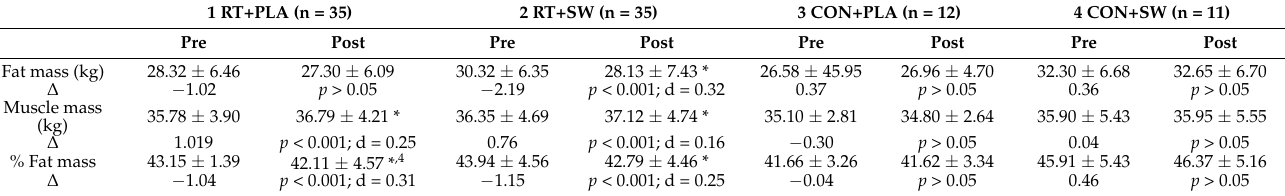
Table 7. Body composition.